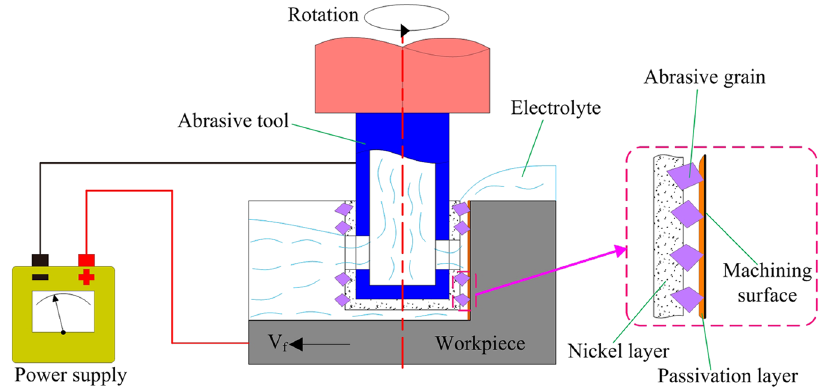
Figure 1. Schematic diagram of inner-jet ECG with the proposed abrasive